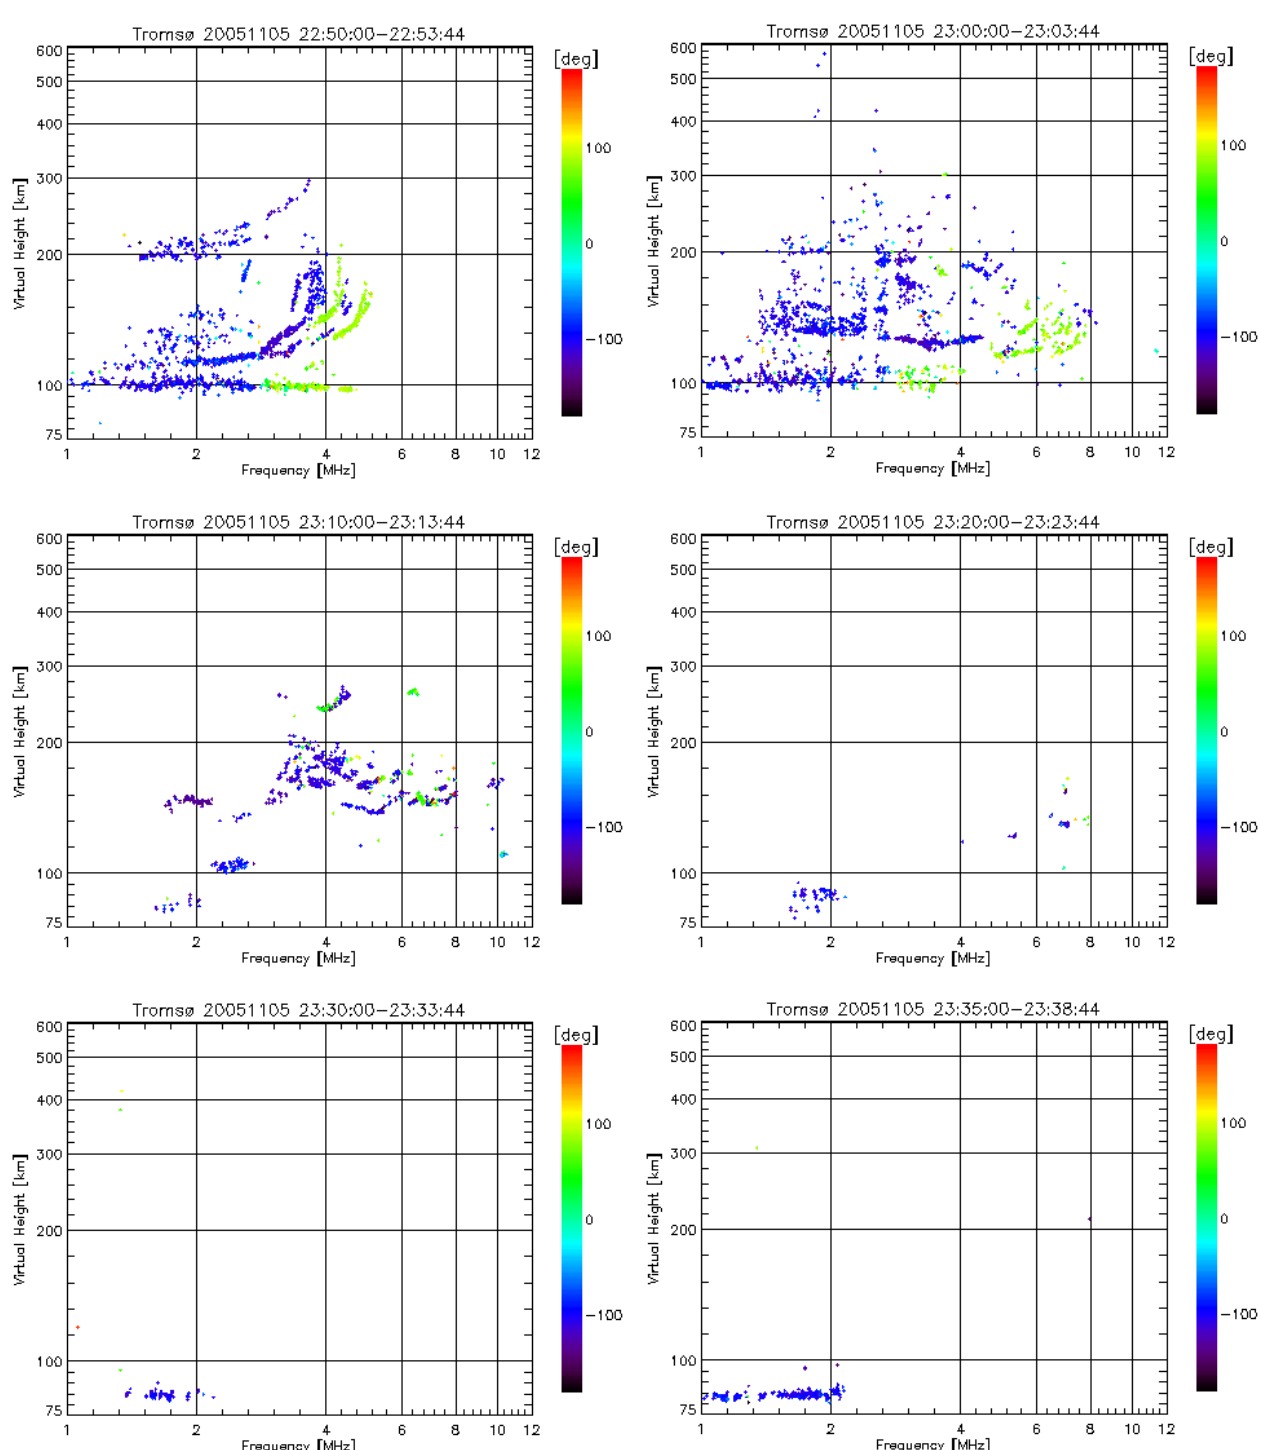
Fig. 6. Ionograms from the EISCAT Tromsø Dynasonde for selected time periods on 5 November 2005. The colour scale shows the chirality of the echoes, +90 ◦ is for X-mode and − 90 ◦ for O-mode